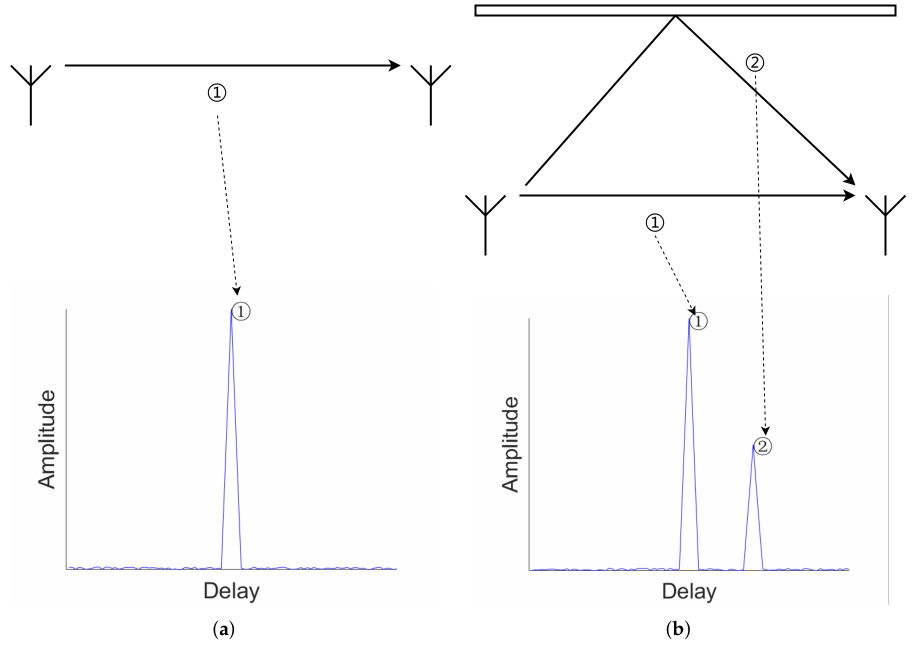
Figure 1. CIR of LOS conditions. ( a ) CIR of ideal LOS condition. ( b ) CIR of real LOS condition.